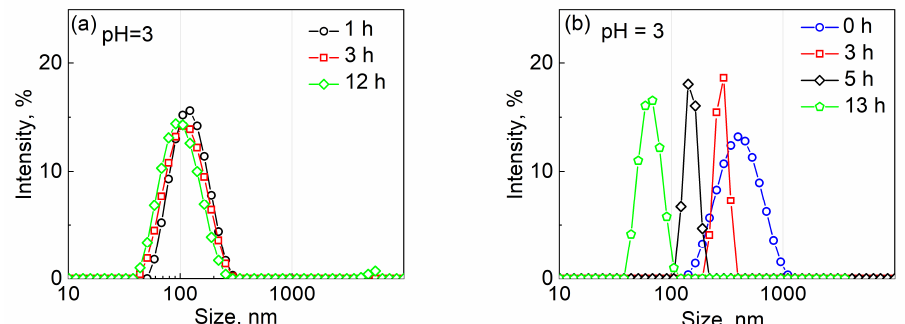
Figure 4. pH-dependent size of DOX-free ( a ) PMOXA 14 -PDMS 65 -PMOXA 14 and ( b ) PVCL 10 -PDMS 65 - PVCL 10 polymersomes in the buffer solution at pH = 3 and 37 °C after 0- (circles) 3- (squares), 5- PVCL 10 polymersomes in the buffer solution at pH = 3 and 37 ◦ C after 0- (circles) 3- (squares), 5- (down-triangles), and 12-h (pentagons) incubation. (down-triangles), and 12-h (pentagons)